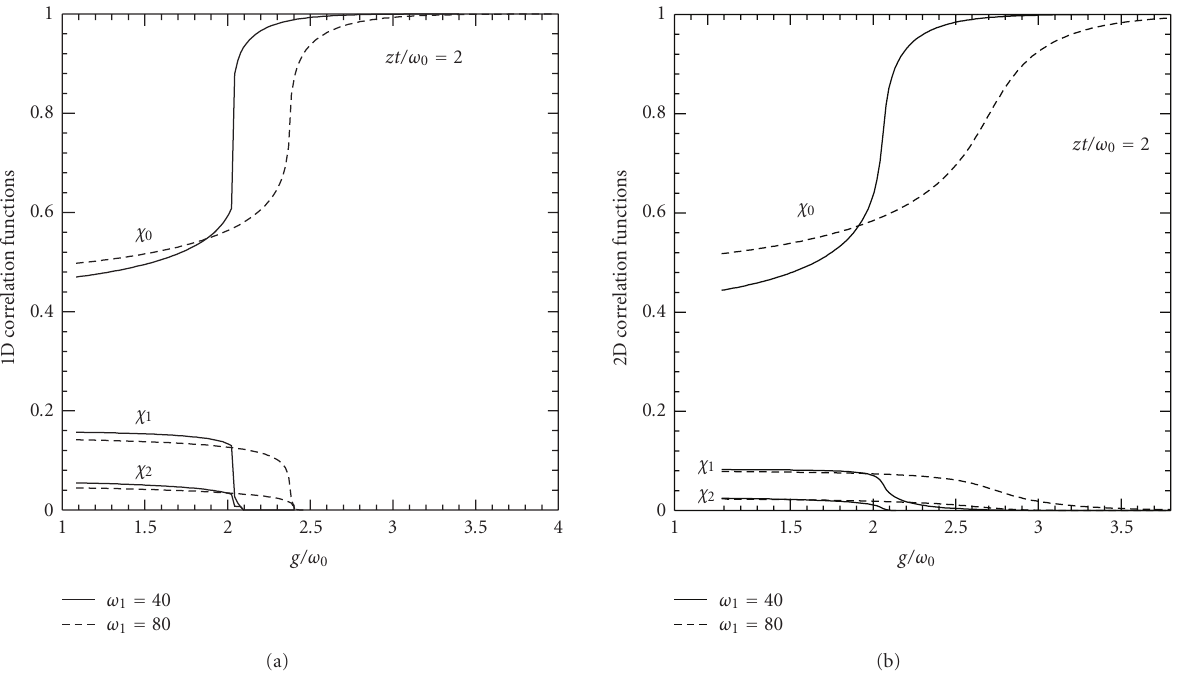
Figure 3: Electron-phonon correlation functions: on-site χ 0 , first neighbor site χ 1 and second neighbor site χ 2 versus e-ph coupling in (a) 1D and (b) 2D. An adiabatic regime is considered and two values of intermolecular energy are assumed.